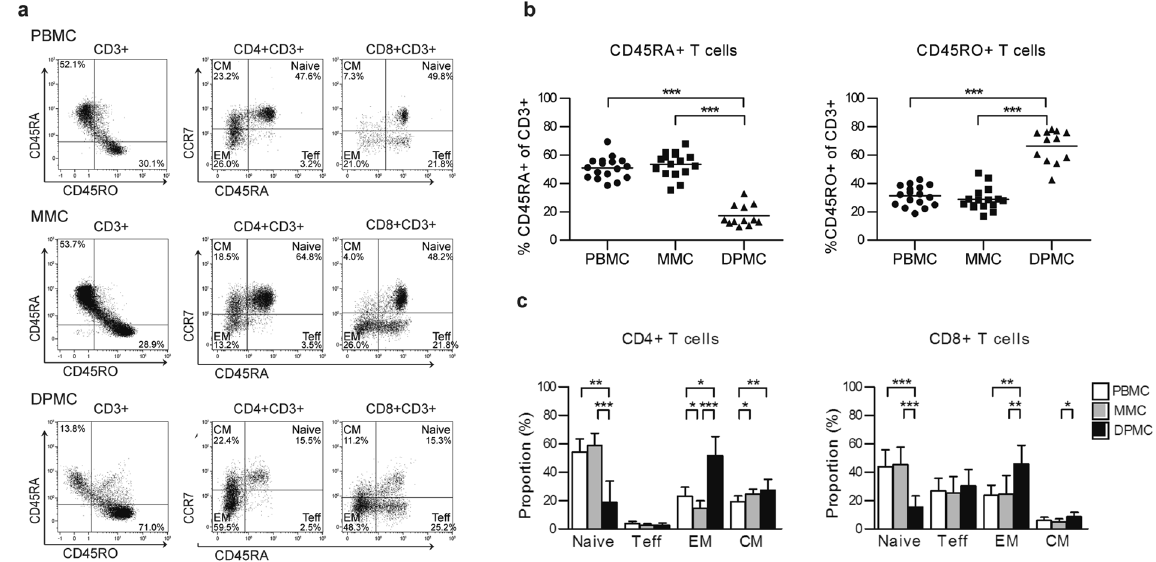
Figure 2. CD4 + and CD8 + T cells subsets in peripheral blood (PBMC), menstrual blood (MMC) and term decidua parietalis (DPMC). ( a ) Representative staining for CD45RA and CD45RO on CD3 + T cells and CD45RA and CCR7 on CD4 + and CD8 + T cells from PBMC, MMC, and DPMC. ( b ) Expression of CD45RA and CD45RO on CD3 + T cells (PBMC n = 17, MMC n = 16, and DPMC n = 12. ( c ) CD4 + and CD8 + T cells are separated into four subsets based on the expression of CD45RA and CCR7. Naive T cell (CD45RA + CCR7 + ); effector T cell, Teff (CD45RA + CCR7 − ); effector memory T cell, EM (CD45RA − CCR7 − ); central memory T cell, CM (CD45RA − CCR7 + ) (PBMC n = 17, MMC n = 11, and DPMC n = 8). Lines indicate mean ± SD. * P < 0.05, ** P < 0.01, and *** P < 0.001 (non-parametric Kruskal-Wallis with Dunns post-hoc test).